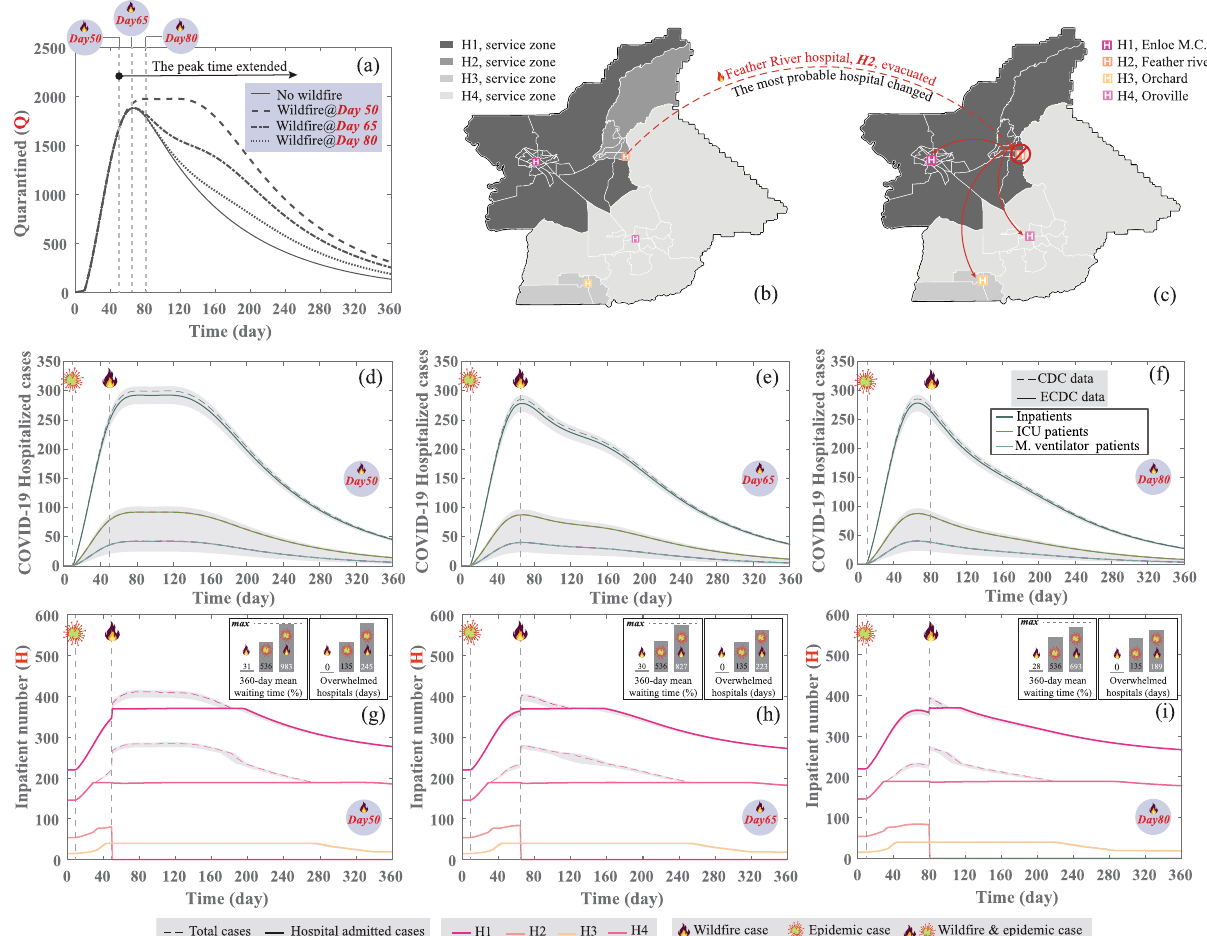
Fig. 2 Compound effects of wild fi re and pandemic. a Impact of wild fi re occurrence and the associated population evacuation on disease transmission in the community, which is highlighted using the distribution of the total quarantined cases that is assumed to be stricken by the wild fi re before, during, and after the COVID-19 peak using the disease transmission rates of the U.S. The distribution of the most probable hospital per census tract for Butte County b before and c after the wild fi re show that most patients in Paradise who have selected the Feather River Hospital before the fi re are now choosing the Enloe Medical Center as an alternative. The distribution of COVID-19 related patients classi fi ed based on the hospitalization service needed for a different time, including d wild fi re occurrence 40 days after the epidemic, e wild fi re occurrence at the peak of the active epidemic cases, and f the wild fi re occurrence during the disease decline period. The distribution of regular, wild fi re and epidemic related patients on different hospitals in Butte County for the time after the epidemic using the disease transmission rates of the U.S. for a different time including g wild fi re occurrence 40 days after the epidemic, h wild fi re occurrence at the peak of the epidemic active cases, and i the wild fi re occurrence during the disease decline period, 70 days after the outbreak. Note: time “ 10 ” marks the occurrence of the outbreak. These fi gures also show the 2.5 and 97.5 percentiles for hospitalization and inpatient cases, calculated using Monte-Carlo simulations with 100,000